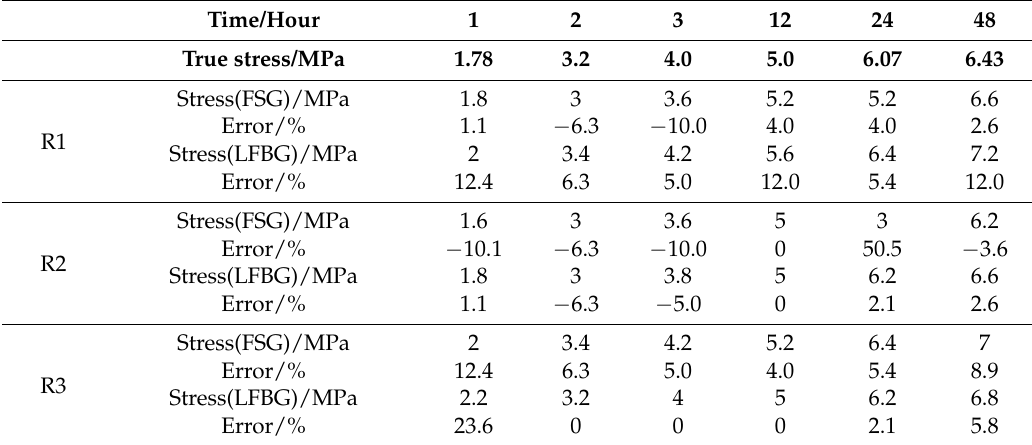
Table 4. The stresses and the measurement errors calculated from the strains obtained from the FSGs and LFBG